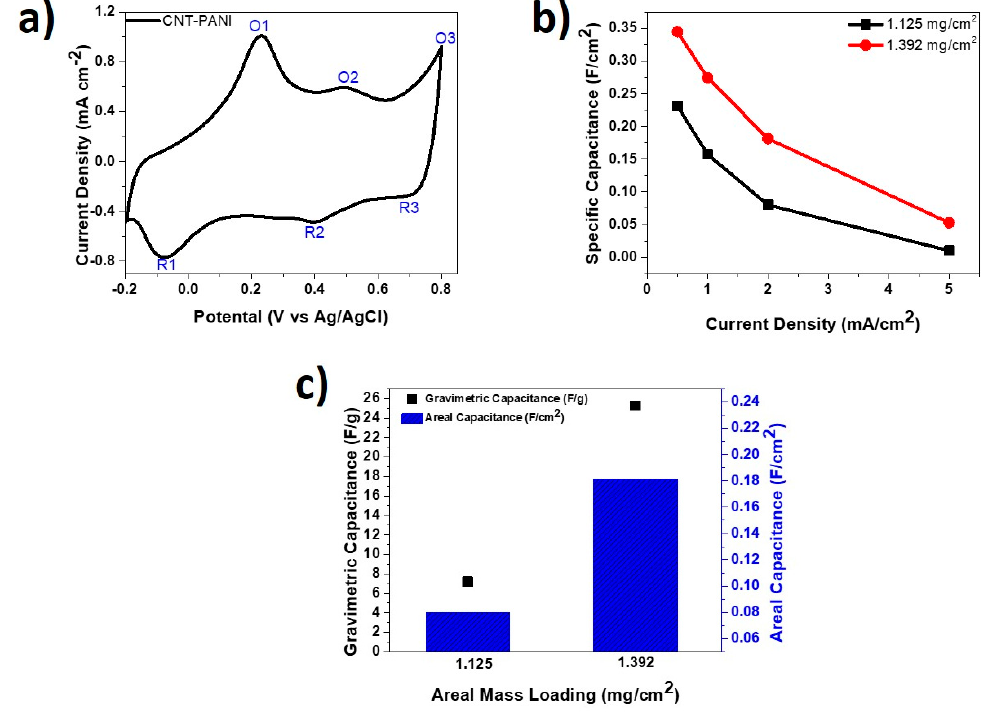
Figure 7. ( a ) CV curve of PANI-CNT fiber at 5 mV/s in H 2 SO 4 electrolyte; ( b ) specific capacitance at various current densities for PANI-CNT fibers; and ( c ) areal and gravimetric specific capacitances for PANI-CNT fibers at current densities of 2 mA/cm 2 and 2 A/g, respectively.